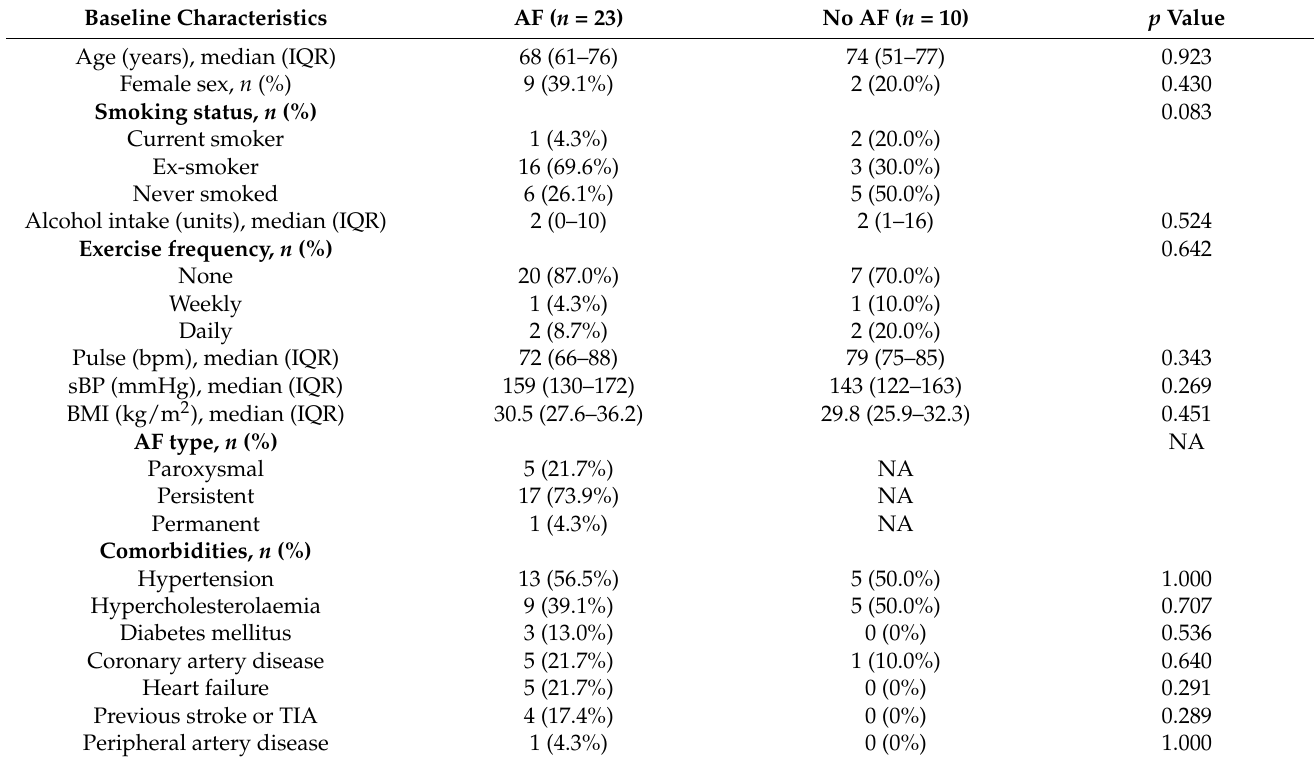
Table 1. Baseline characteristics of patients with and without atrial